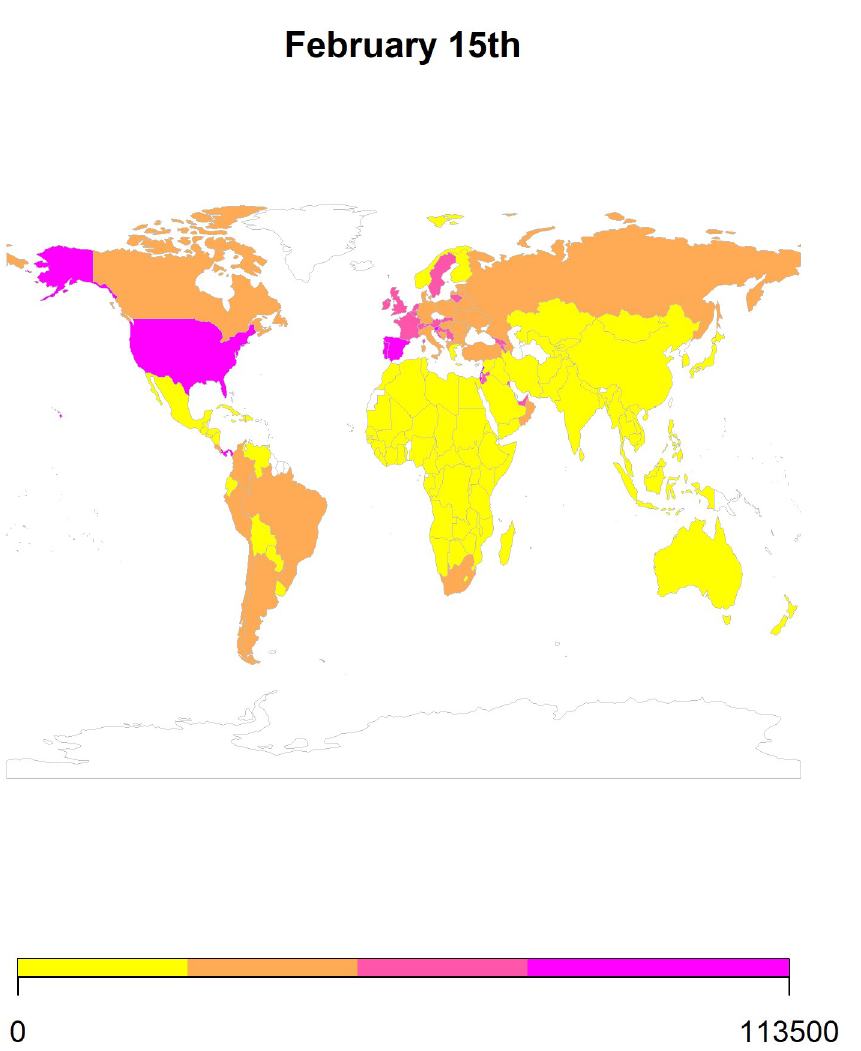
Fig 8. The heat map using the ARIMA forecasts for 15 th February